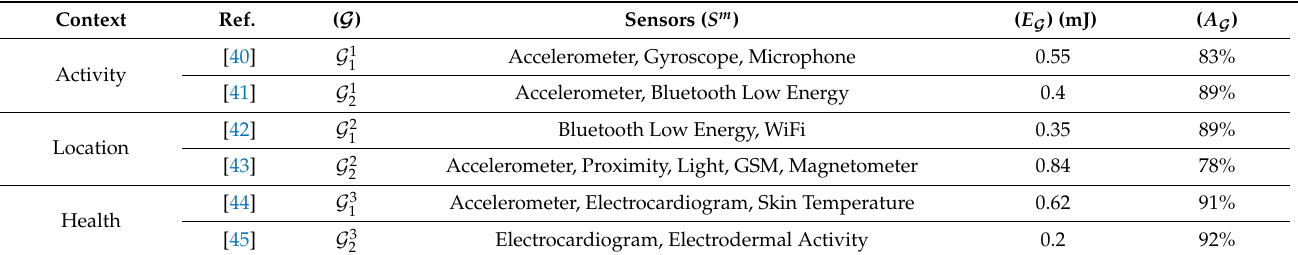
Table 1. CRM KB sensor groups’ data.